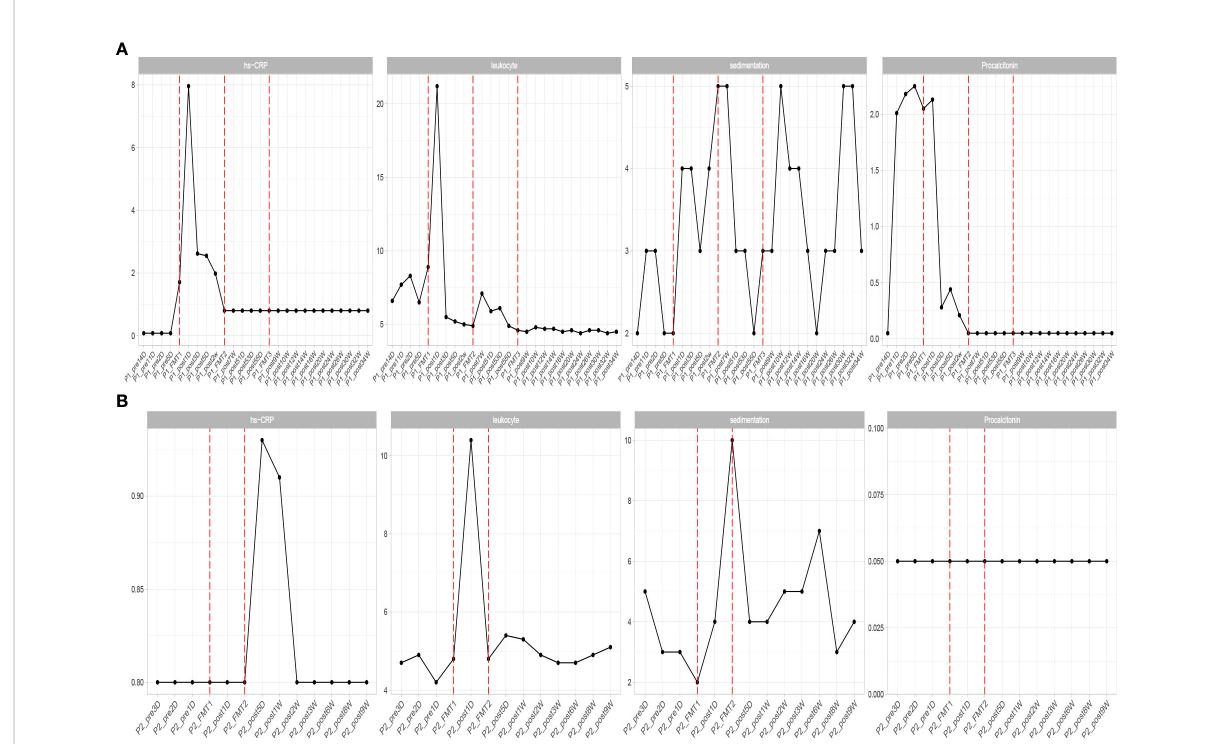
Figure 1, the glycosylated hemoglobin of the patient decreased slightly after each transplantation and remained stable after the completion of transplantation. The glycosylated hemoglobin level after fecal microbiota transplants (6.55 ± 0.07%) of the patient was not signi fi cantly different from before